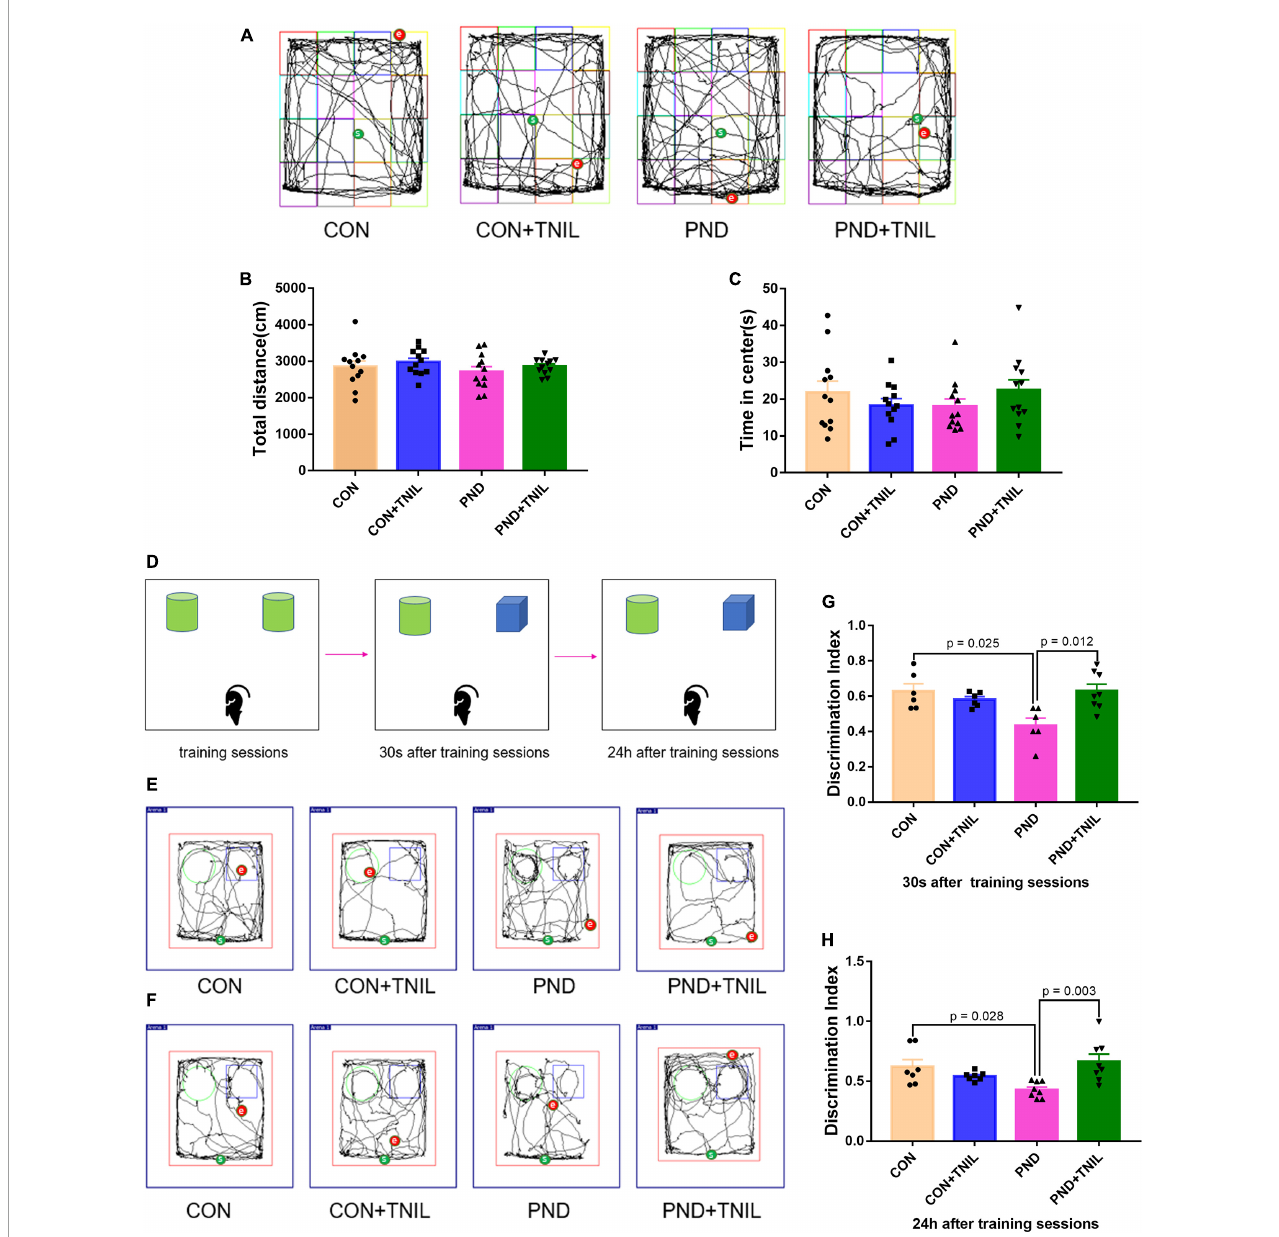
FIGURE2 Transcranial near-infrared laser alleviated anesthesia-/surgery-induced cognitive dysfunction in aged mice. (A) Representative movement traces of OFT. (B) The total distance among four groups in OFT. (C) Time spent in the center among four groups in OFT. (D) The schematic diagram of NOR. (E,F) The representative movement traces at 30 s and 24 h after training sessions of NOR. (G,H) Performance in NOR. Data are shown as mean ± SEM ( n =